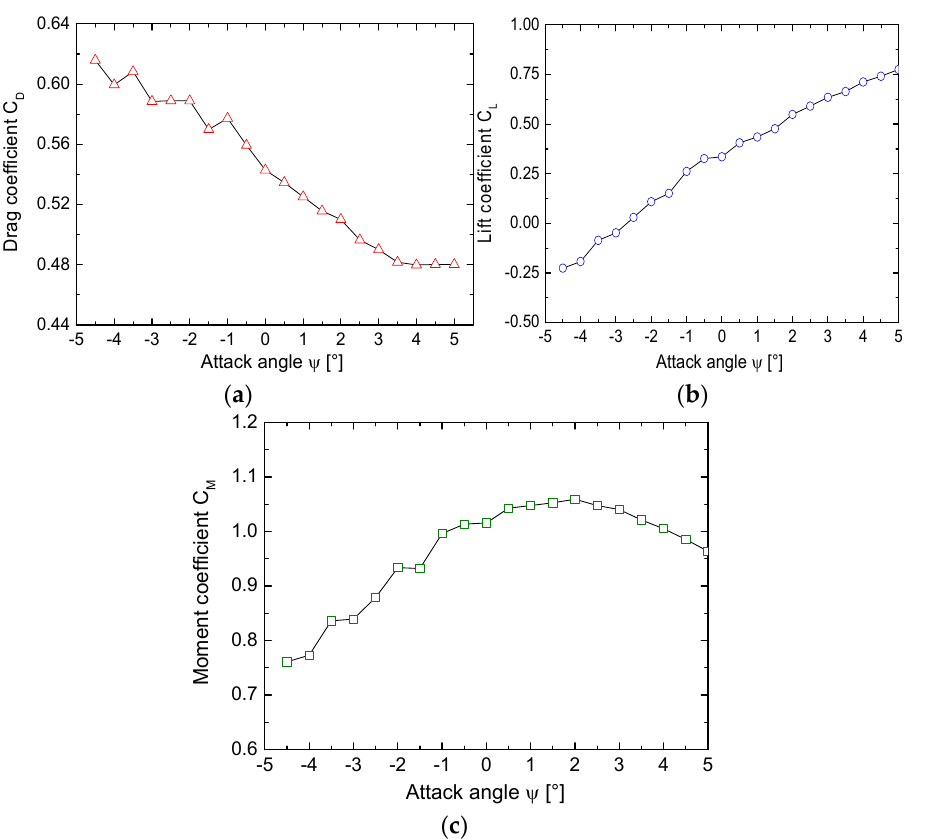
Figure 12. The measured aerodynamic force coefficients of the bridge with different attack angles, ( a ) drag coefficient, ( b ) lift coefficient, ( c ) moment coefficient.